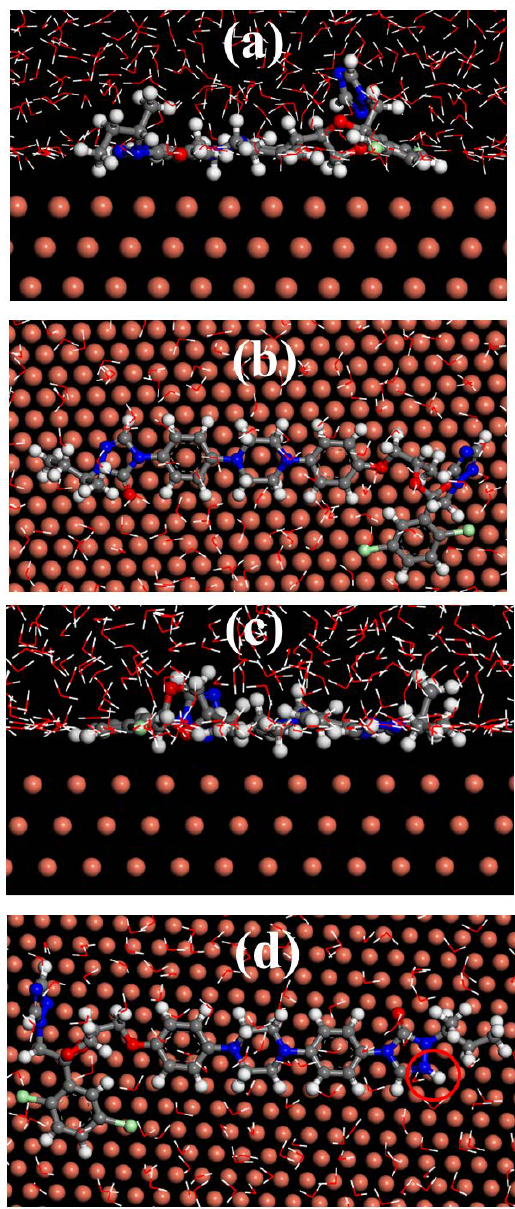
Figure 11. The stable configuration of itraconazole and itraconazole after protonation adsorbed on Cu (111) surface: ( a ) side view plot of itraconazole, ( b ) top view plot of itraconazole, ( c ) side view plot of itraconazole itraconazole after protonation, and ( d ) top view plot of itraconazole after protonation.